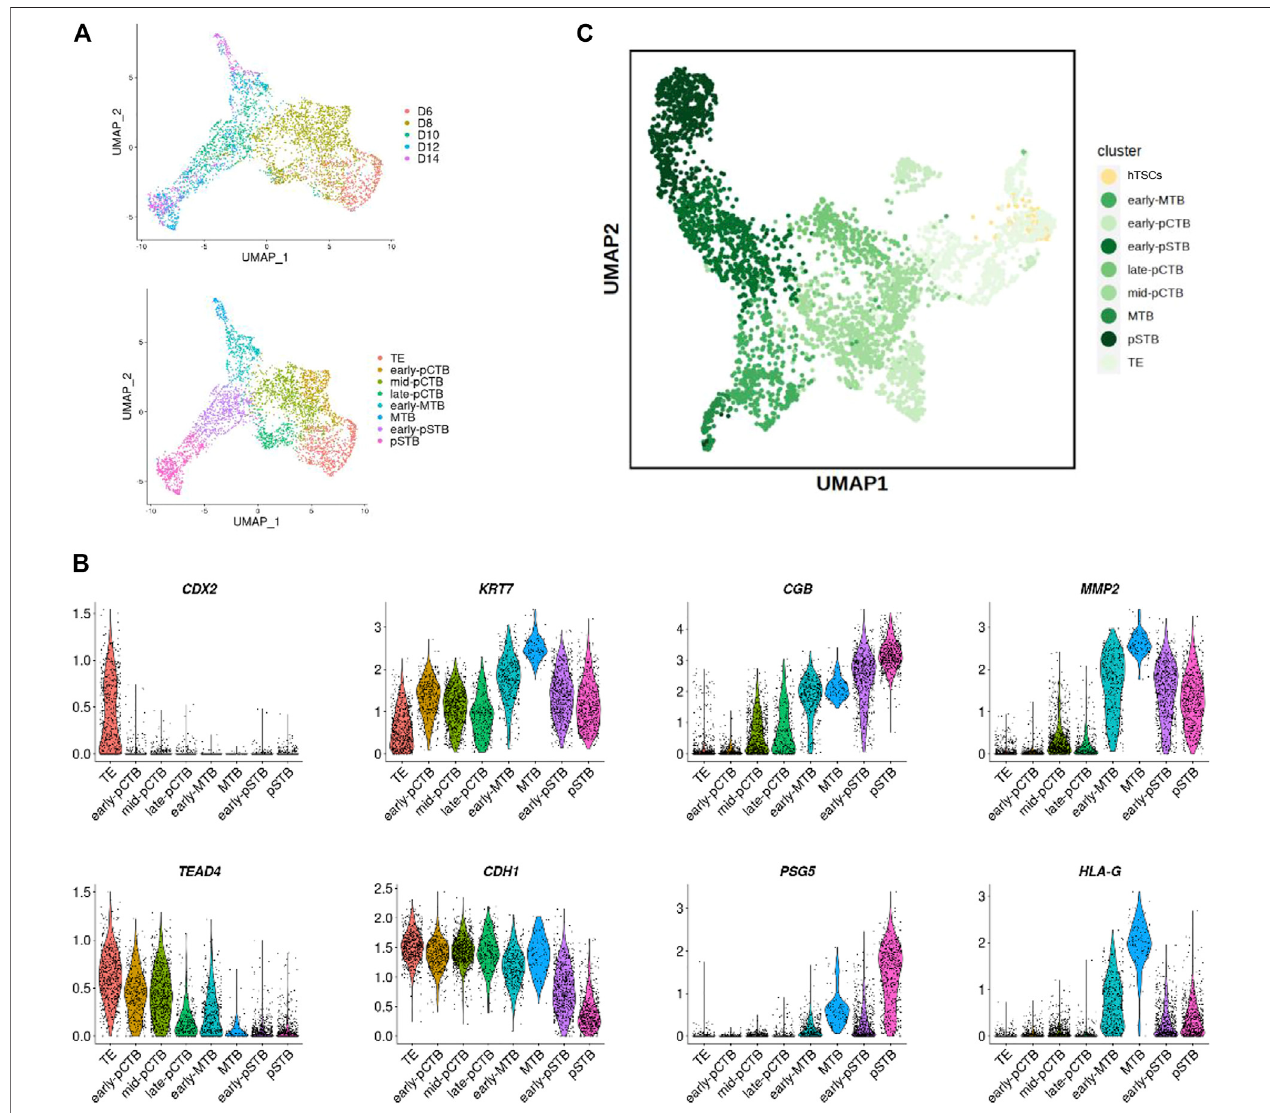
FIGURE 3 | Developmental matching of hTSCs with peri-implantation trophoblast cells of human embryos. (A) UMAP plots showing the expression patterns of trophoblast cells in human embryos. Upper, different time points; Lower, different clusters. (B) Violin plots showing the expression patterns of marker genes. (C) Joint visualization of hTSCs together with trophoblast cells from published datasets of human embryos cultured in vitro .